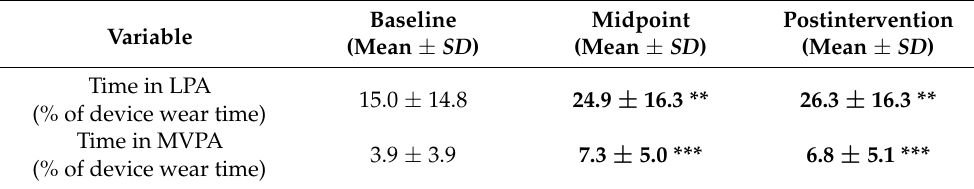
Table 2. Descriptive statistics for objective physical activity at each